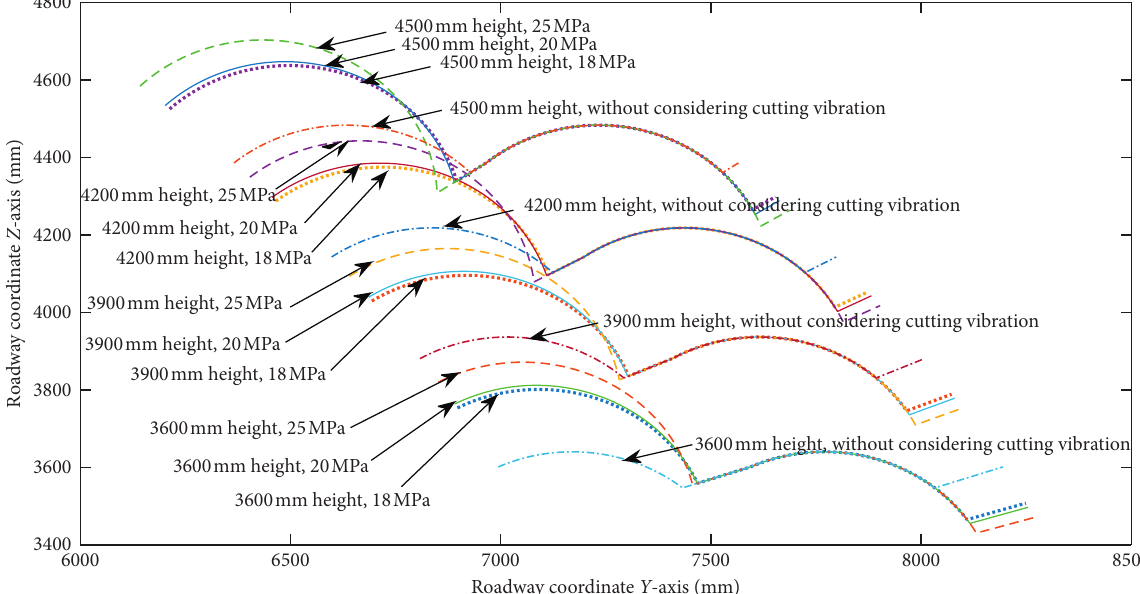
Figure 10: The effect of different cutting heights on contour